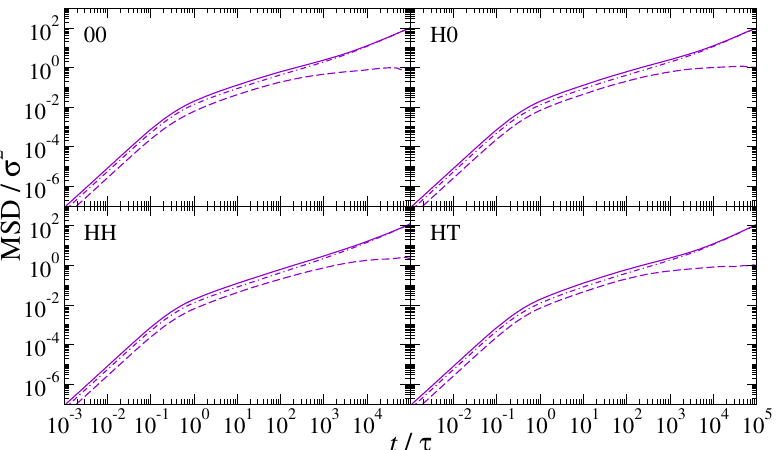
Figure 8. Mean squared displacement of neutral and Janus NDs at 5 wt% in 3D-space (continuous lines), within the lamellar xy plane (dashed-dotted lines) and along the z direction (dashed